Question: Sum up the contents of this chart in one sentence.
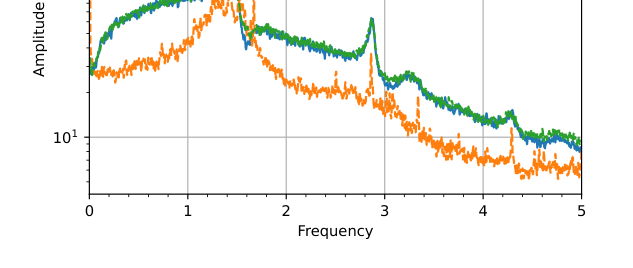
Answer: Fourier Spectrum of a predicted time series in the closed- loop configuration with a reservoir size of N = 30. The true system is depicted as a solid blue line, while the classic linear regression and the attention-enhanced reservoir are shown as dashed orange and green lines, respectively